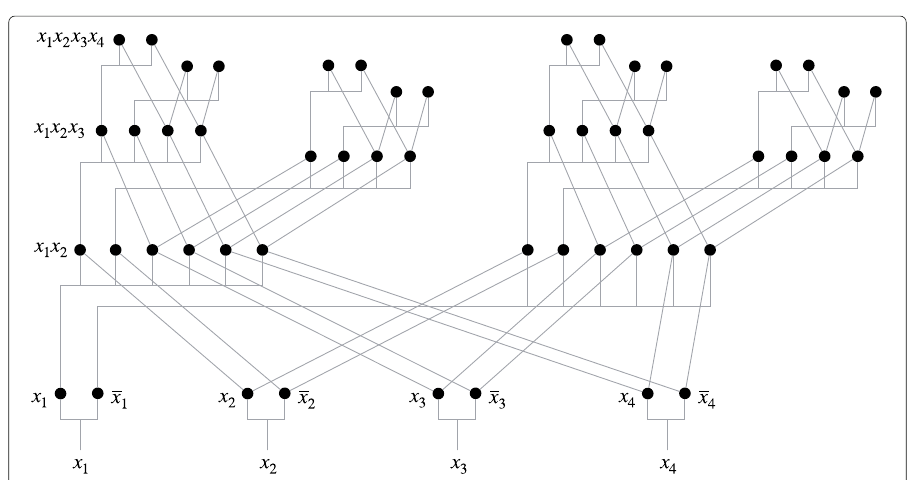
Fig. 1 Universal decoder network for four variables. The different conjunctions of input binary variables are realized from this